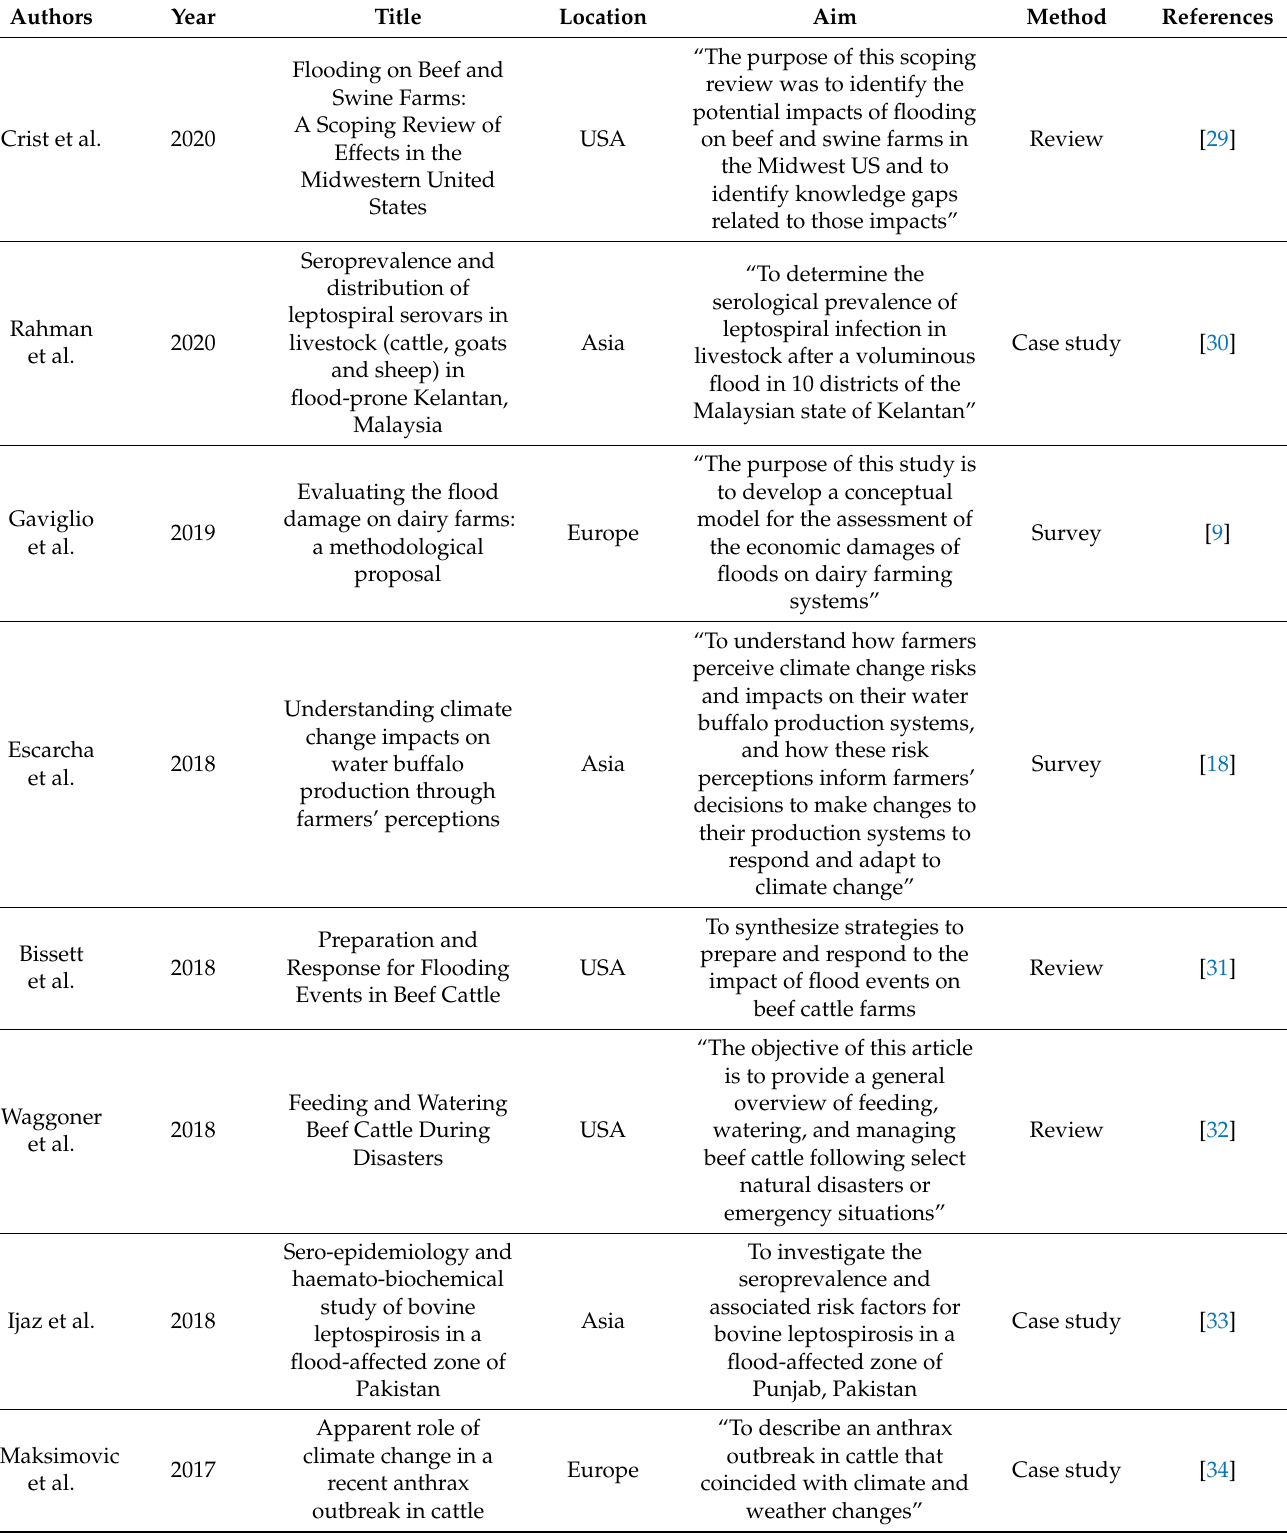
Table 1. Final sample of papers